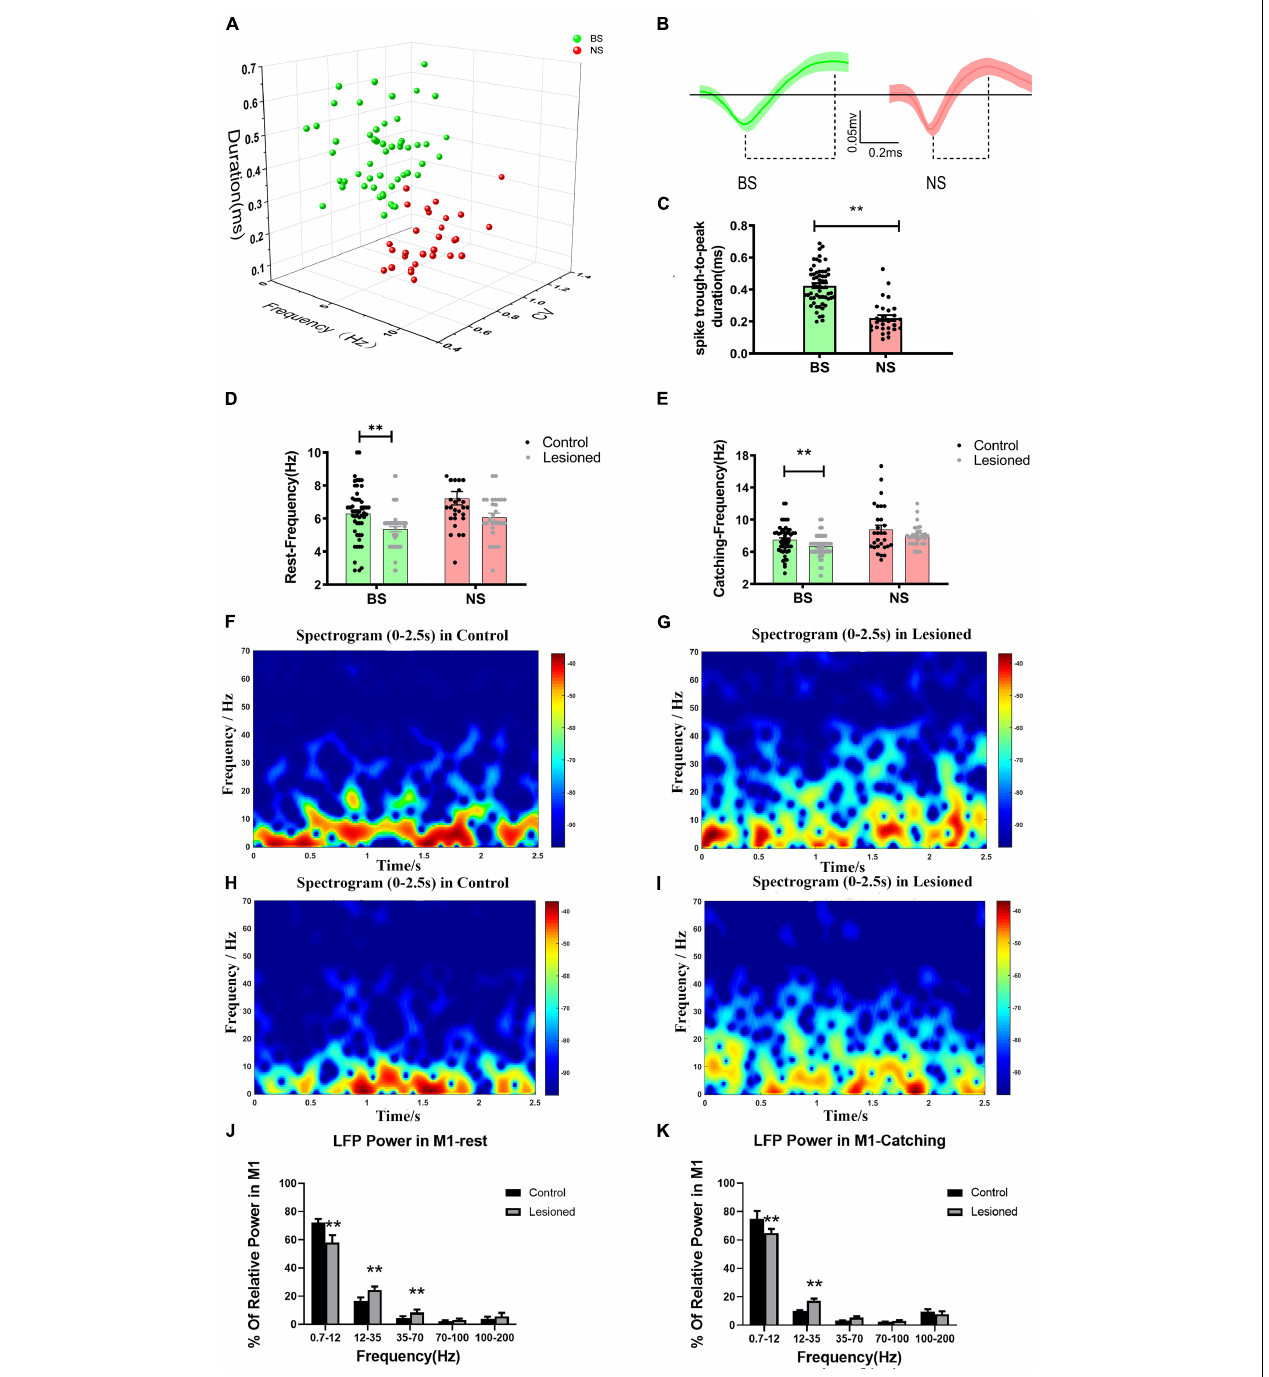
FIGURE 4 | Neuron classification in the M1 and alterations in firing rate and LFP power for the two types of neurons. (A) Corresponding cluster analysis of all recorded neurons according to duration and firing properties in 3D view. (B) Waveforms of the two types of neurons in M1 (green, broad spike, BS; red, narrow spike, NS). Dotted lines below the waveforms show their through-to peak durations. (C) Statistical results of the through-to peak durations of all recorded neurons between the two subtypes of neurons were different. (D) The bar and scatter plot showed the mean frequency from BS (the green bar) neurons and NS neurons (the red bar) during resting and (E) catching movement states respectively, with black dots for the control rats and gray dots for the 6-OH DA-treated rats. Spectrograms of LFP power from the M1 in the (F) control rats and the (G) lesioned rats during resting states. Spectrograms of LFP power from the M1 in the (H) control rats and the (I) lesioned rats during catching movement states. (J) Bar graphs showed the mean relative LFP power from different frequency bands between the control rats (the black bars) and the 6-OHDA-treated rats (the gray bars) during resting and (K) catching movement states respectively. Error bars represent SEM, and ** indicates p <